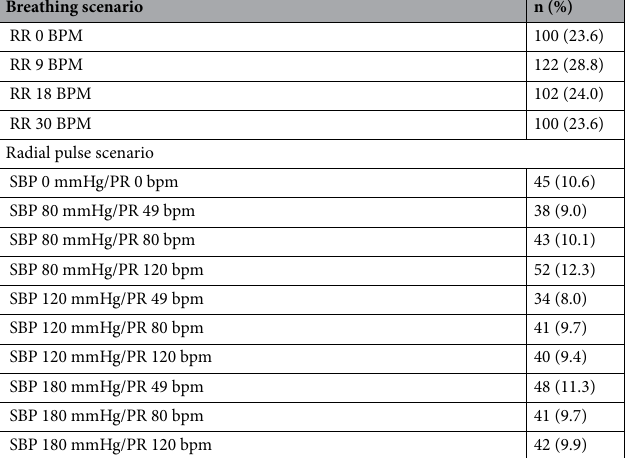
Table 2. The number of breathing and radial pulse scenarios. RR respiratory rate, BPM breaths per minute, bpm beats per minute, SBP systolic blood pressure, PR pulse rate. Four scenarios of breathing were defined: ‘no breathing’, RR = 0 BPM; ‘slow’, RR = 9 BPM; ‘normal’, RR = 18 BPM; and ‘fast’, RR = 30 BPM. All respiratory sounds were turned off in the simulator. Ten scenarios of radial pulse were defined: ‘no pulse’, SBP = 0 mmHg and PR = 0 bpm; ‘weak’, SBP = 80 mmHg; ‘normal’, SBP = 120 mmHg; and ‘strong’, SBP = 180 mmHg. Radial pulse rate was categorised as follows: ‘slow’, PR = 49 bpm; ‘normal’ PR = 80 bpm; and ‘fast’, PR = 120